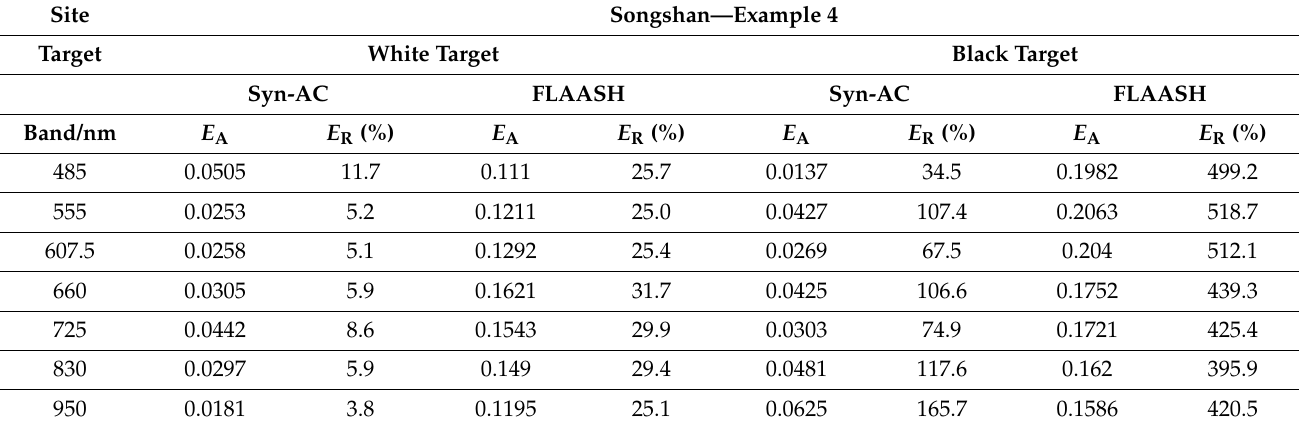
Table 11. Performance comparison between Syn-AC and FLAASH, based on Example 4.